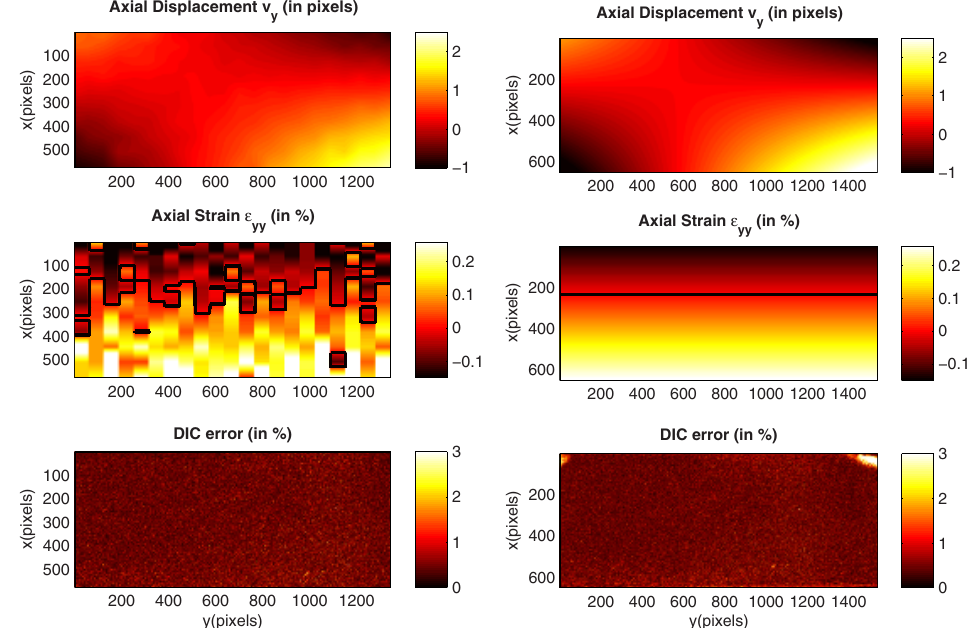
- i.e. a neutral axis located at the mid-height of the beam section (Figure 2). This elastic approach is widely adopted in the literature and in the industry to characterize aluminium titanate at room temperature or at high temperature [10]. It is not possible to quantify the strength of such damageable ceramics from only the de(cid:13)ection and load measurements. There- fore one needs to have access the full strain (cid:12)eld during a four-point bending test. The Q4-DIC and beam-DIC approaches are now used to achieve this full (cid:12)eld measurement for one of the (cid:12)ve samples : Using the Q4-DIC approach (198 elements / size length = 64 pixels), the measured displace- ment (cid:12)eld amplitudes v y are so small that the corresponding strain values (cid:15) yy are not reliable (Figure 3). Using the beam-DIC approach with one element, the measured displacement (cid:12)eld v y and the corresponding axial strain (cid:12)eld (cid:15) yy are more regular and accurate. The axial strain (cid:12)eld measured during the bending test reveals a dissymmetric behaviour. At the failure load, the beam-DIC approach yields to maximum strains of +0.26 % for the